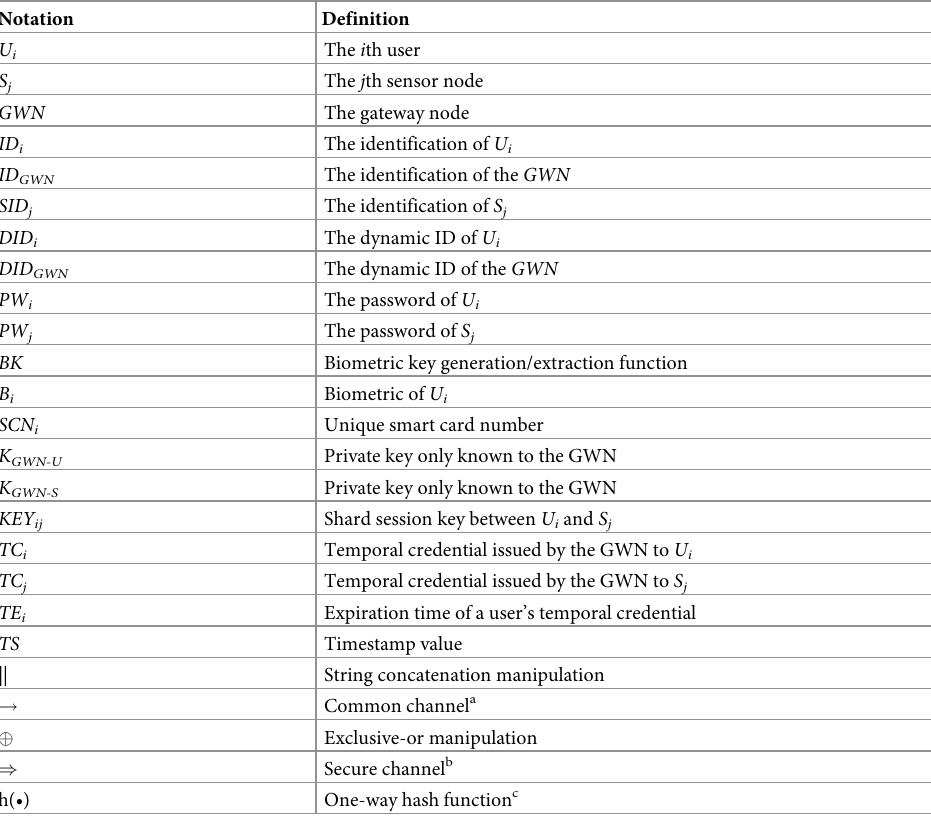
Table 1. Notation